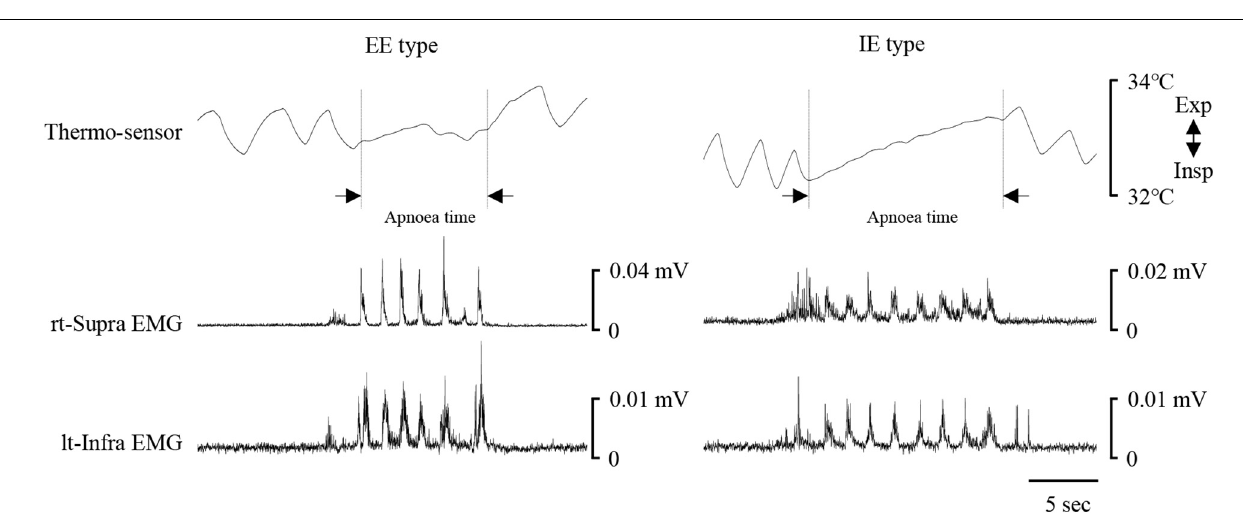
FIGURE 6 | Examples of respiratory and swallowing recordings during 100-ml water swallowing. Electromyography (EMG) waveforms were rectified and smoothed. Left and right cases show expiration–swallow–expiration (EE) type and inspiration–swallow–expiration (IE) type, respectively. Although the participants held their breath during swallowing, nasal temperature gradually increased, possibly because of difference between nasal temperature and air temperature of the experimental room. The period of swallowing apnoea (Apnoea time) is shown by dotted lines. lt-Infra, left infrahyoid, rt-Supra, right